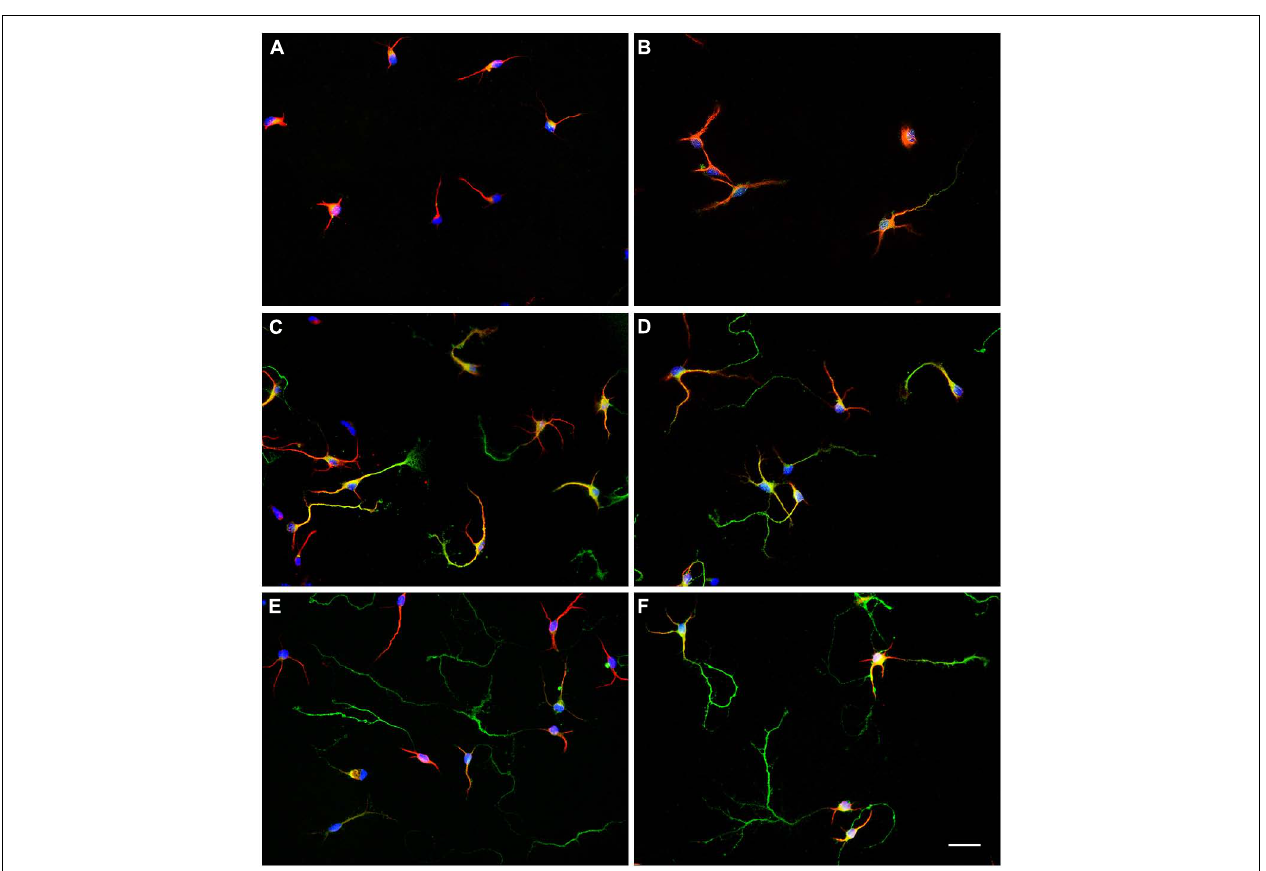
FIGURE 2 | Representative examples of hypothalamic neurons from male and female embryos at different days in vitro (DIV). (A) 2 DIV, male; (B) 2 DIV, female; (C) 4 DIV, male; (D) 4 DIV, female; (E) 6 DIV, male; (F) 6 DIV, female. Scale bar, 20 μ m.